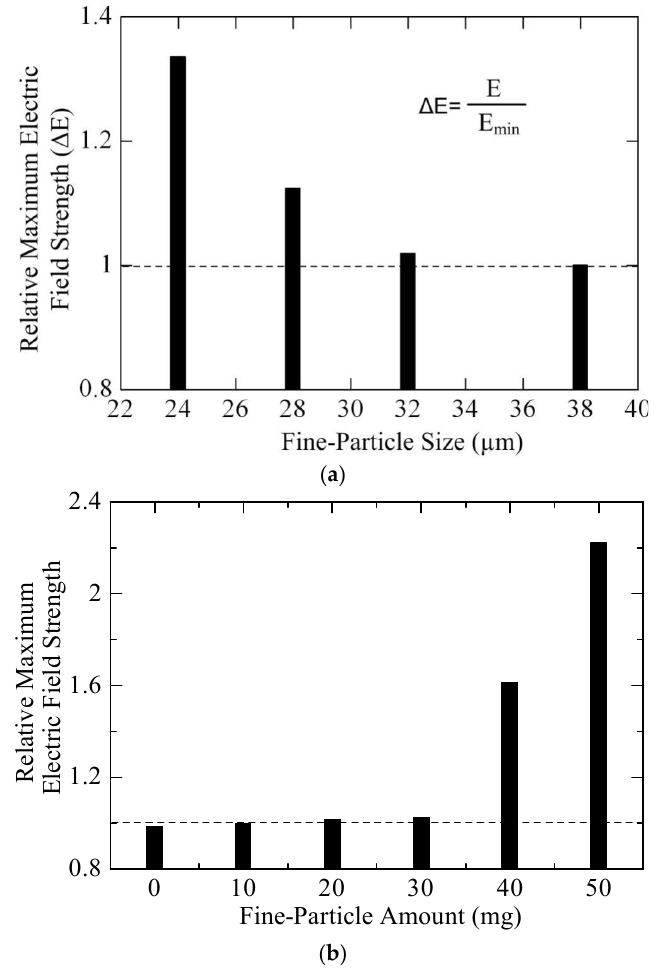
Figure 10. Maximum electric ‐ field strength on polymer insulator specimen surface in relation with variation of fine ‐ particle parameters. ( a ) Effects of fine ‐ particle size with a particle amount of 10 mg; ( b ) Effects of fine ‐ particle amounts with a particle size of 24 μ m.